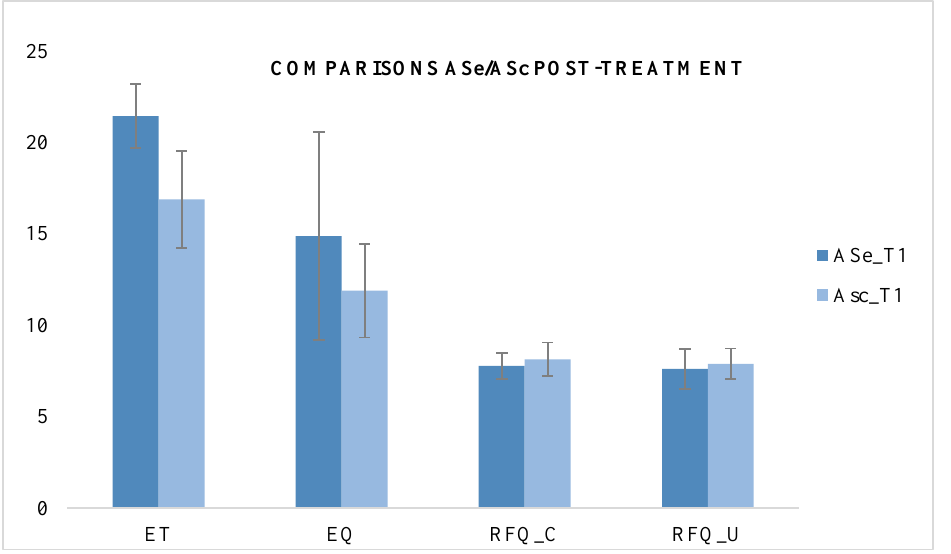
Figure 2. Comparison between ASe and ASc at T1.